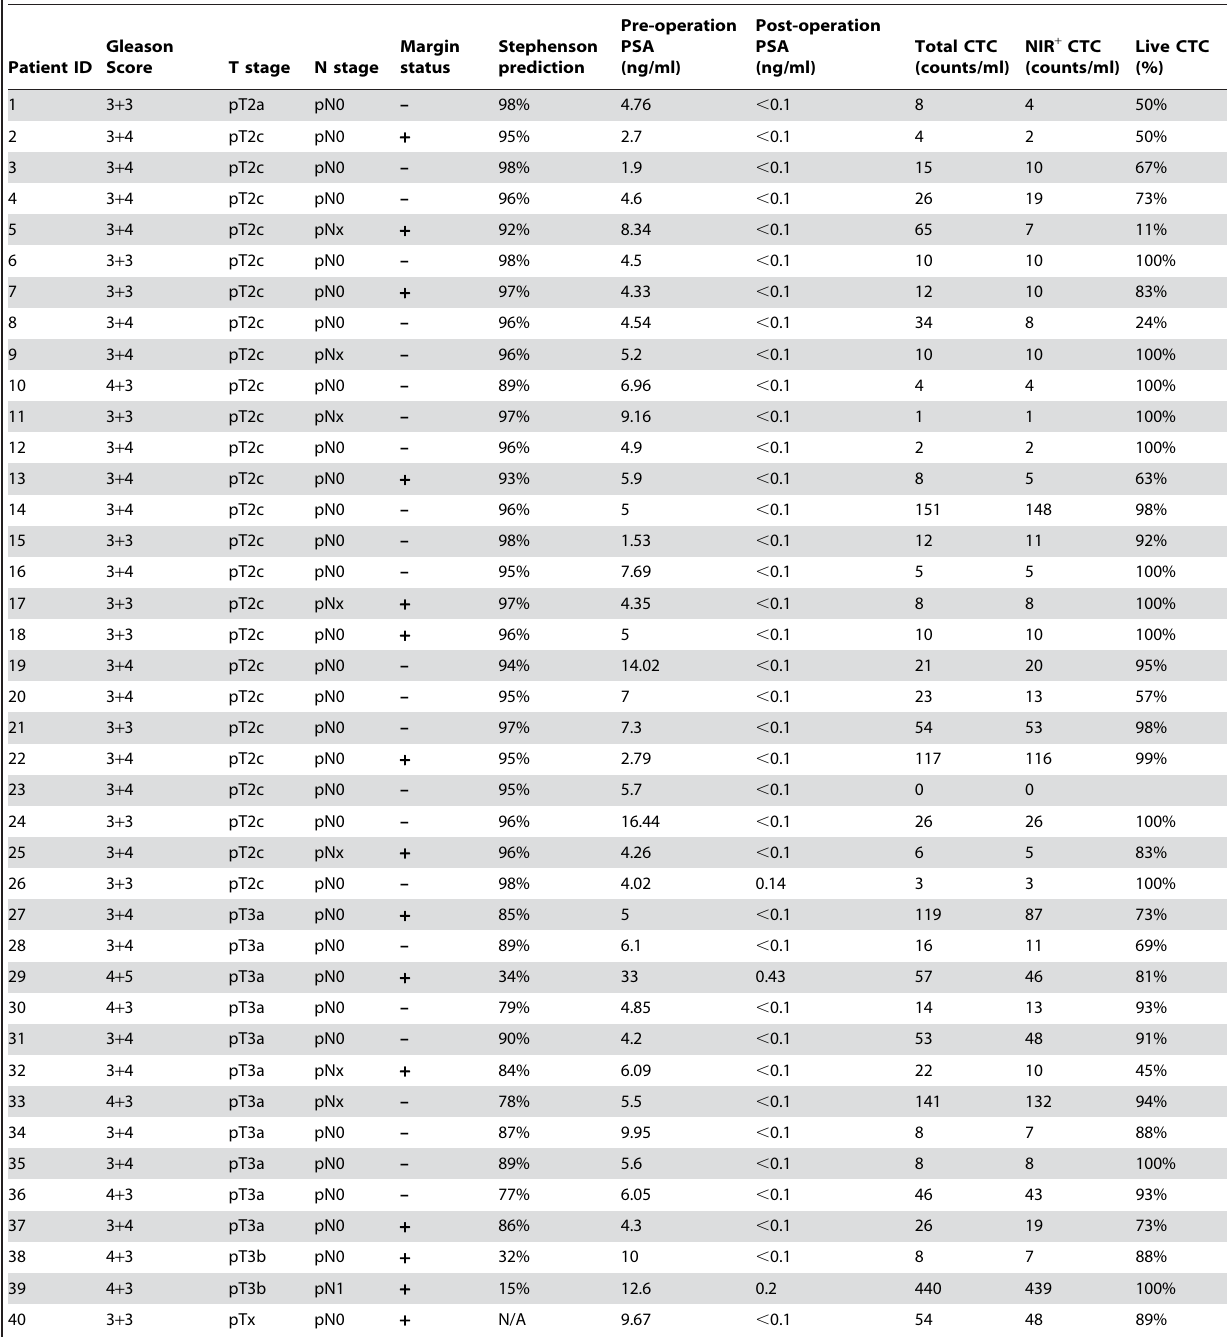
Table 1. Detailed summary of the patients undergoing prostatectomy.